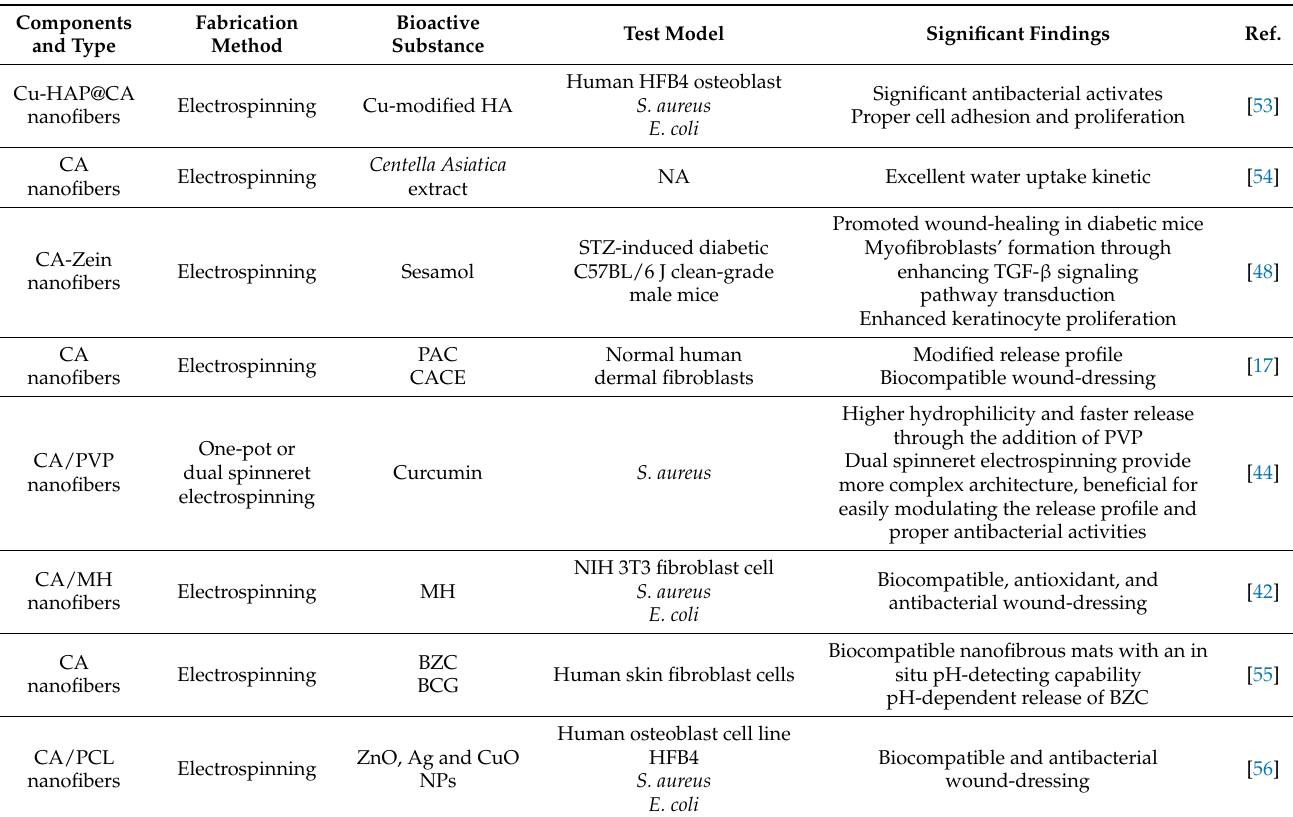
Table 1. CMC-based biomaterials fabricated and applied for wound-healing applications. The fonts are not the same in all cases of the